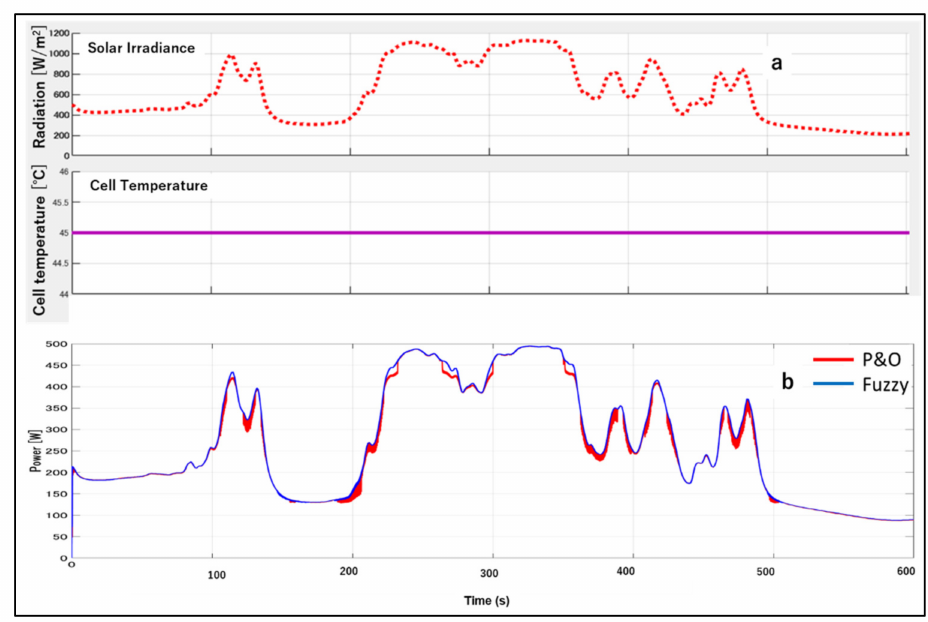
Figure 19. Comparison between the FLC-based and P&O-based MPPT systems for PV (cloudy day): ( a ) Weather conditions; ( b ) Output